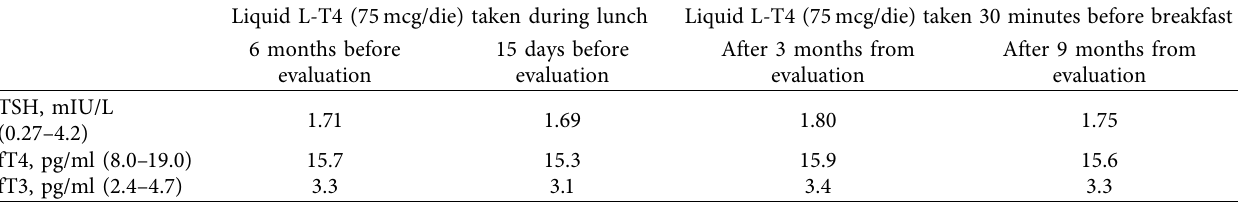
Table 1: Thyroid function tests while taking liquid levothyroxine during lunch and before breakfast at the same daily dose.